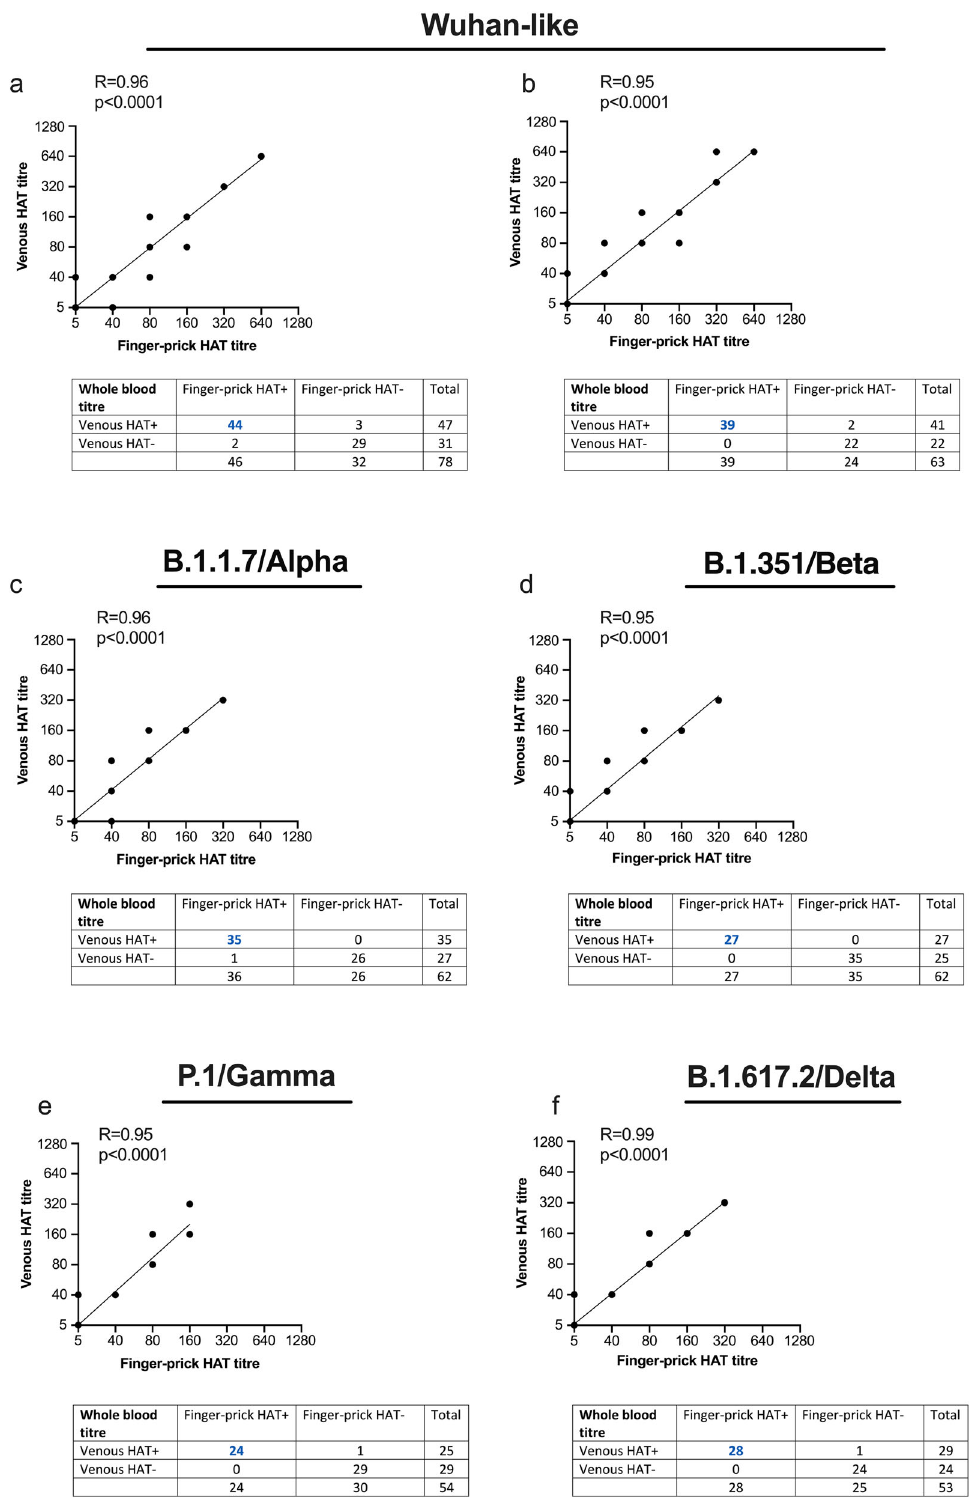
Fig. 3 Correlation of fi nger-prick and venous blood samples using the haemagglutination test on Wuhan and variants of concern. Correlation of paired fi nger-prick and venous blood samples collected from vaccinated healthcare workers. HAT titres are shown by a symbol that can represent on or more blood samples. Correlations were analysed by linear regression shown in graphs and tables. a The point haemagglutination test (HAT) showing the correlation between fi nger-prick and venous whole blood samples ( n = 78). Haemagglutination was scored as shown in the contingency table. “ HAT + ” samples with haemagglutination and “ HAT − “ refers to no haemagglutination or endpoint titres <5. b – f Endpoint HAT titres of paired fi nger-prick and venous blood samples. Diluted fi nger-prick or venous whole blood samples (1 in 40 in phosphate buffered saline (PBS)) were centrifuged, and the supernatant was titrated in the HAT assay using IH4-RBD-reagents and autologous red blood cells (RBC) (washed and diluted 1 in 40 in PBS). b Wuhan- like ( n = 63), c B1.1.7/Alpha ( n = 62), d B.1.351/Beta ( n = 62), e P1/Gamma, ( n = 54), and f B.1.617.2/Delta ( n =